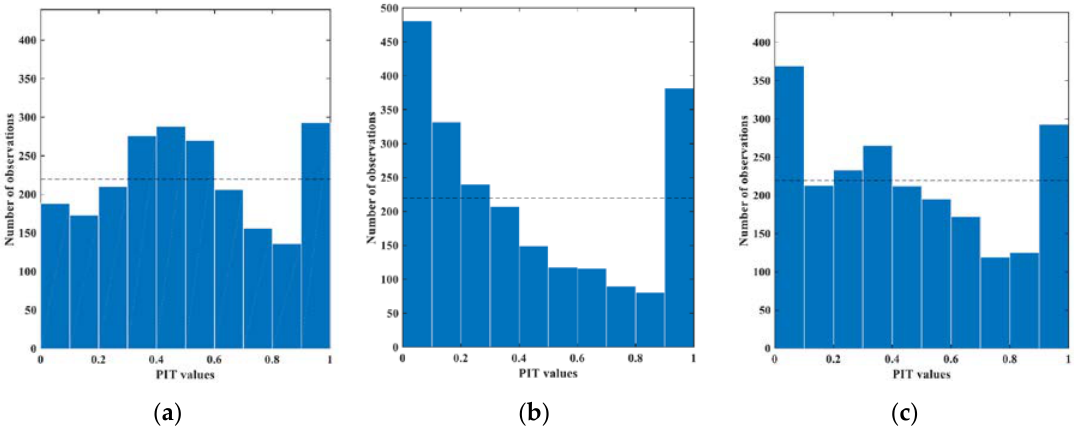
Figure 4. Probability integral transform (PIT) histograms: ( a ) VBNN, ( b ) GPR, ( c ) HMM (black horizontal dashed line: the theoretical uniform frequency).